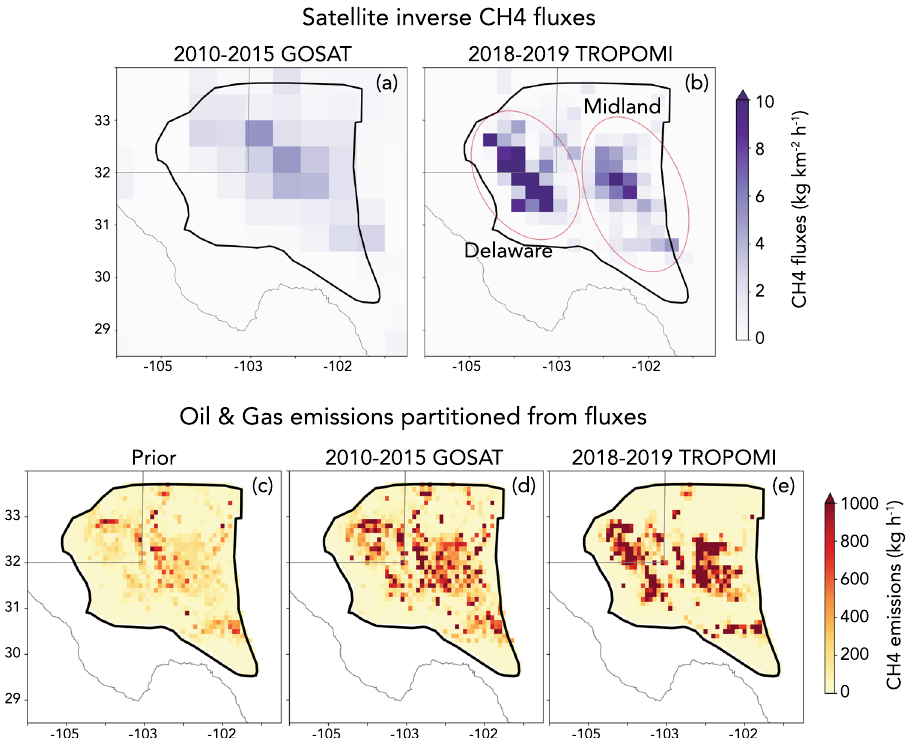
Fig. 3 Comparison of two satellite inverse fl ux whose emissions were optimized using the same prior in the Permian Basin (black outline). Panel a shows the 2010 – 2015 GOSAT inverse fl ux result over the Permian Basin. Panel b shows the 2018 – 2019 TROPOMI inverse fl ux 13 , with the Delaware and Midland basins circled in red. Panel c is the prior oil and gas inventory used for partitioning 15 . Panels d and e represent posterior oil and gas emissions, optimized from fl uxes in panels a and b ,